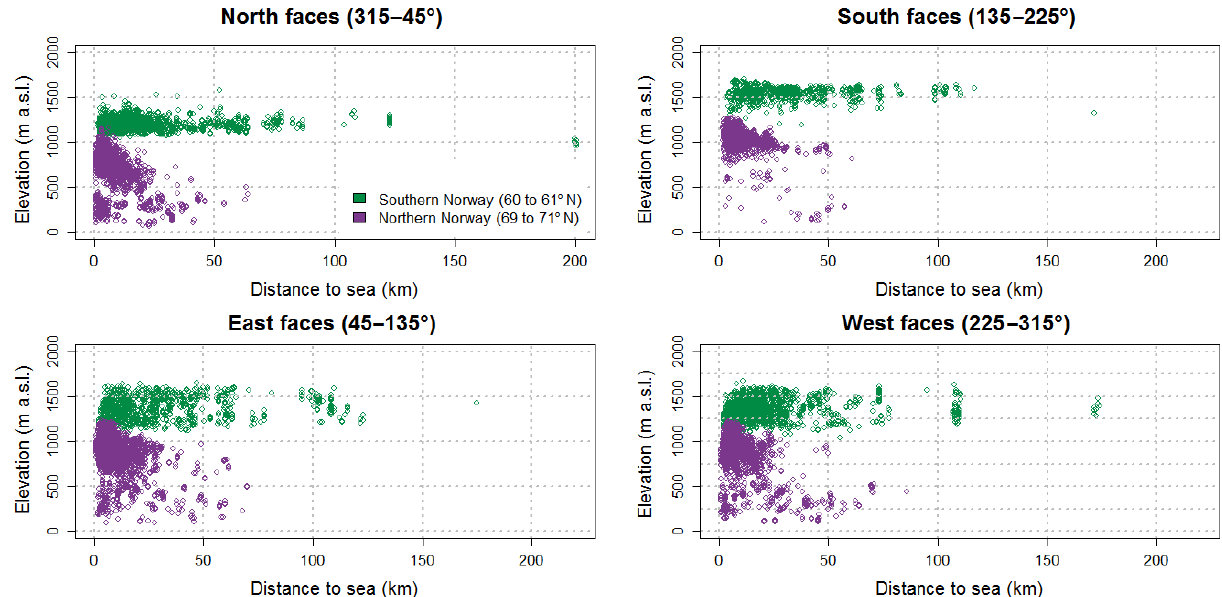
Figure 10. Distribution of the lower limit of discontinuous permafrost in southern and northern Norway according to the distance to the